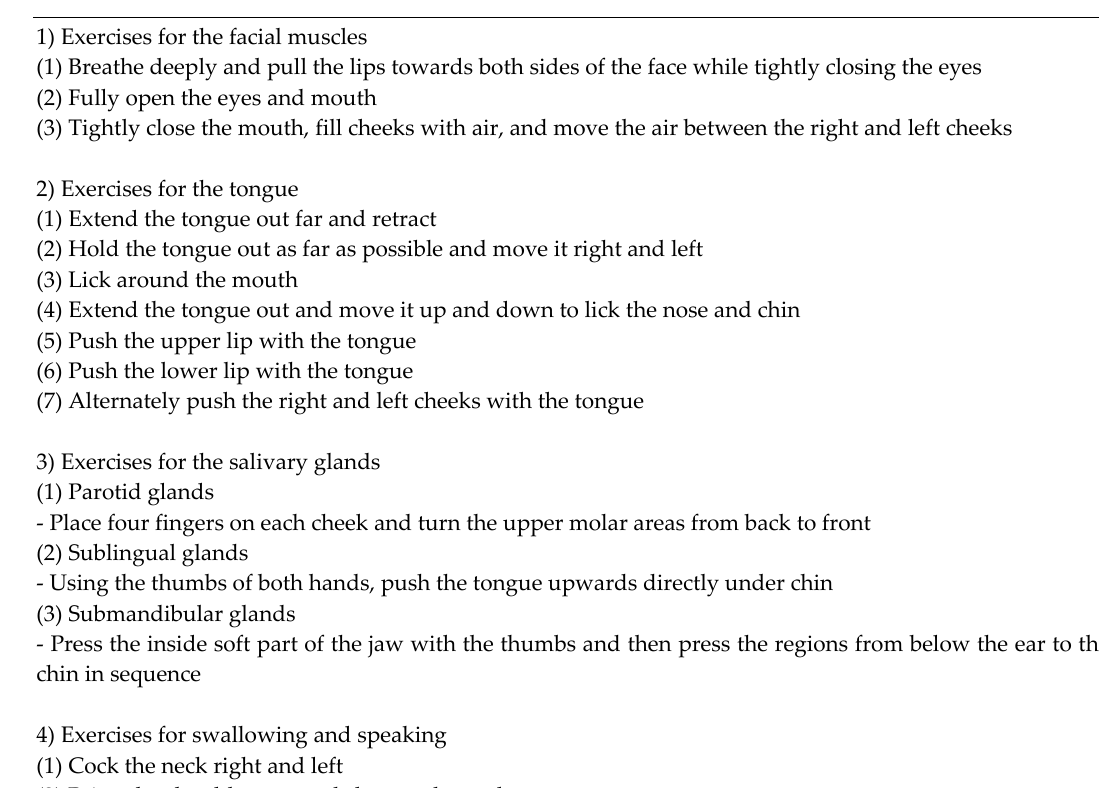
Figure 3. The oral function exercise program consisting of four exercises (exercises focusing on the facial muscles, tongue, salivary glands, and swallowing).